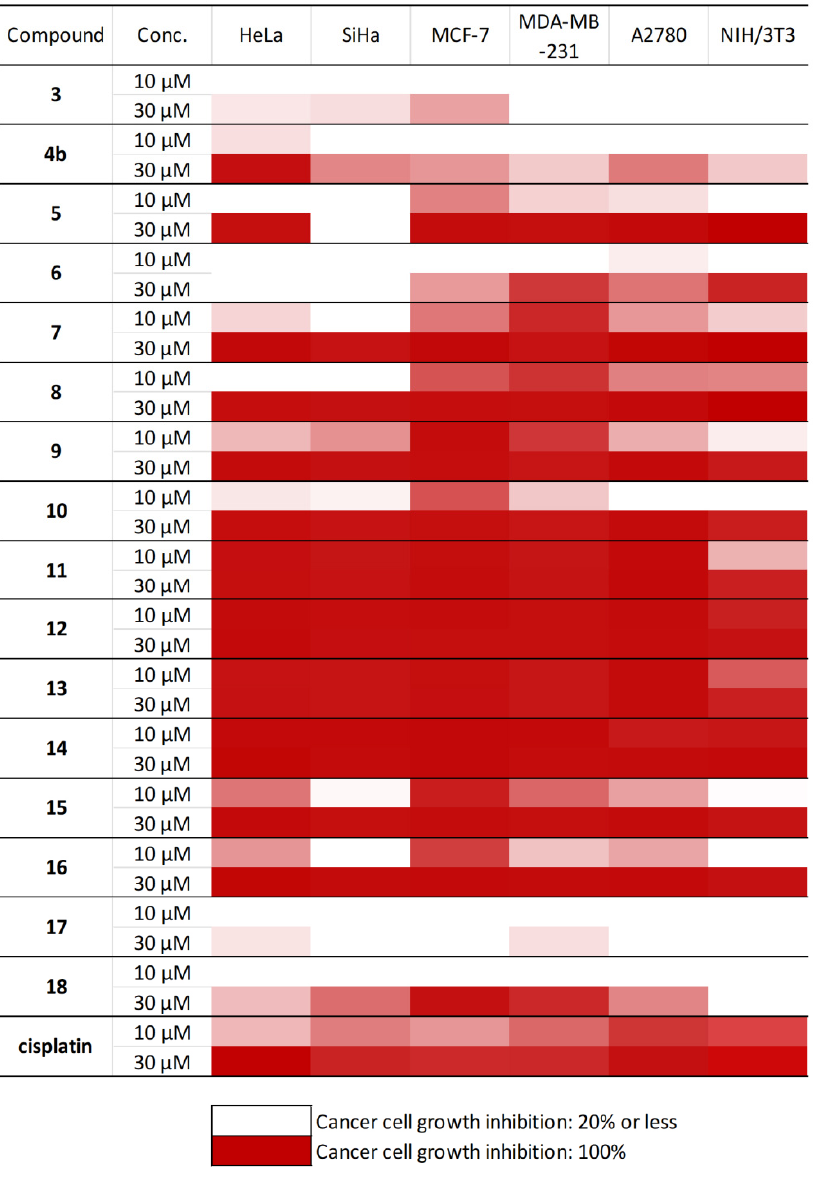
Figure 3. Antiproliferative properties of the prepared steviol analogues against cancer cells and NIH/3T3